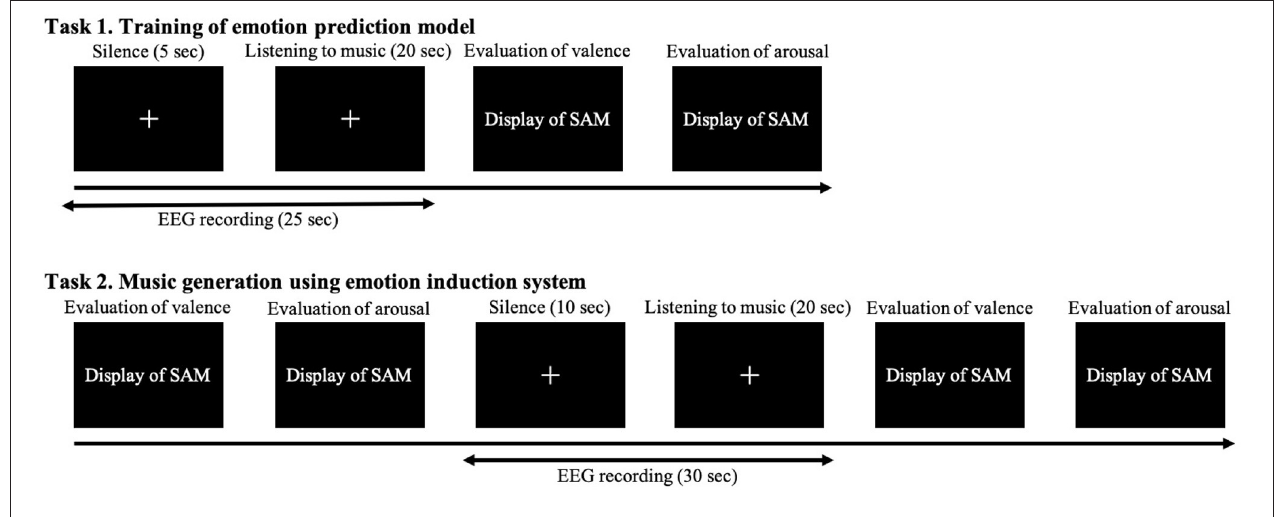
FIGURE 6 | Experimental protocol.